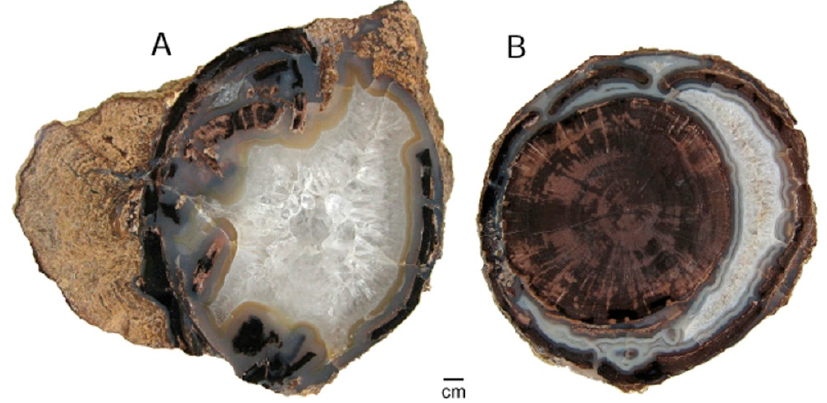
Figure 20. Coarsely-crystalline quartz fills large voids in some Blue Forest specimens. ( A ) Quartz filling interior spaces in decayed wood. ( B ) Quartz was also precipitated in the peripheral spaces, where thin layers of chalcedony provide a